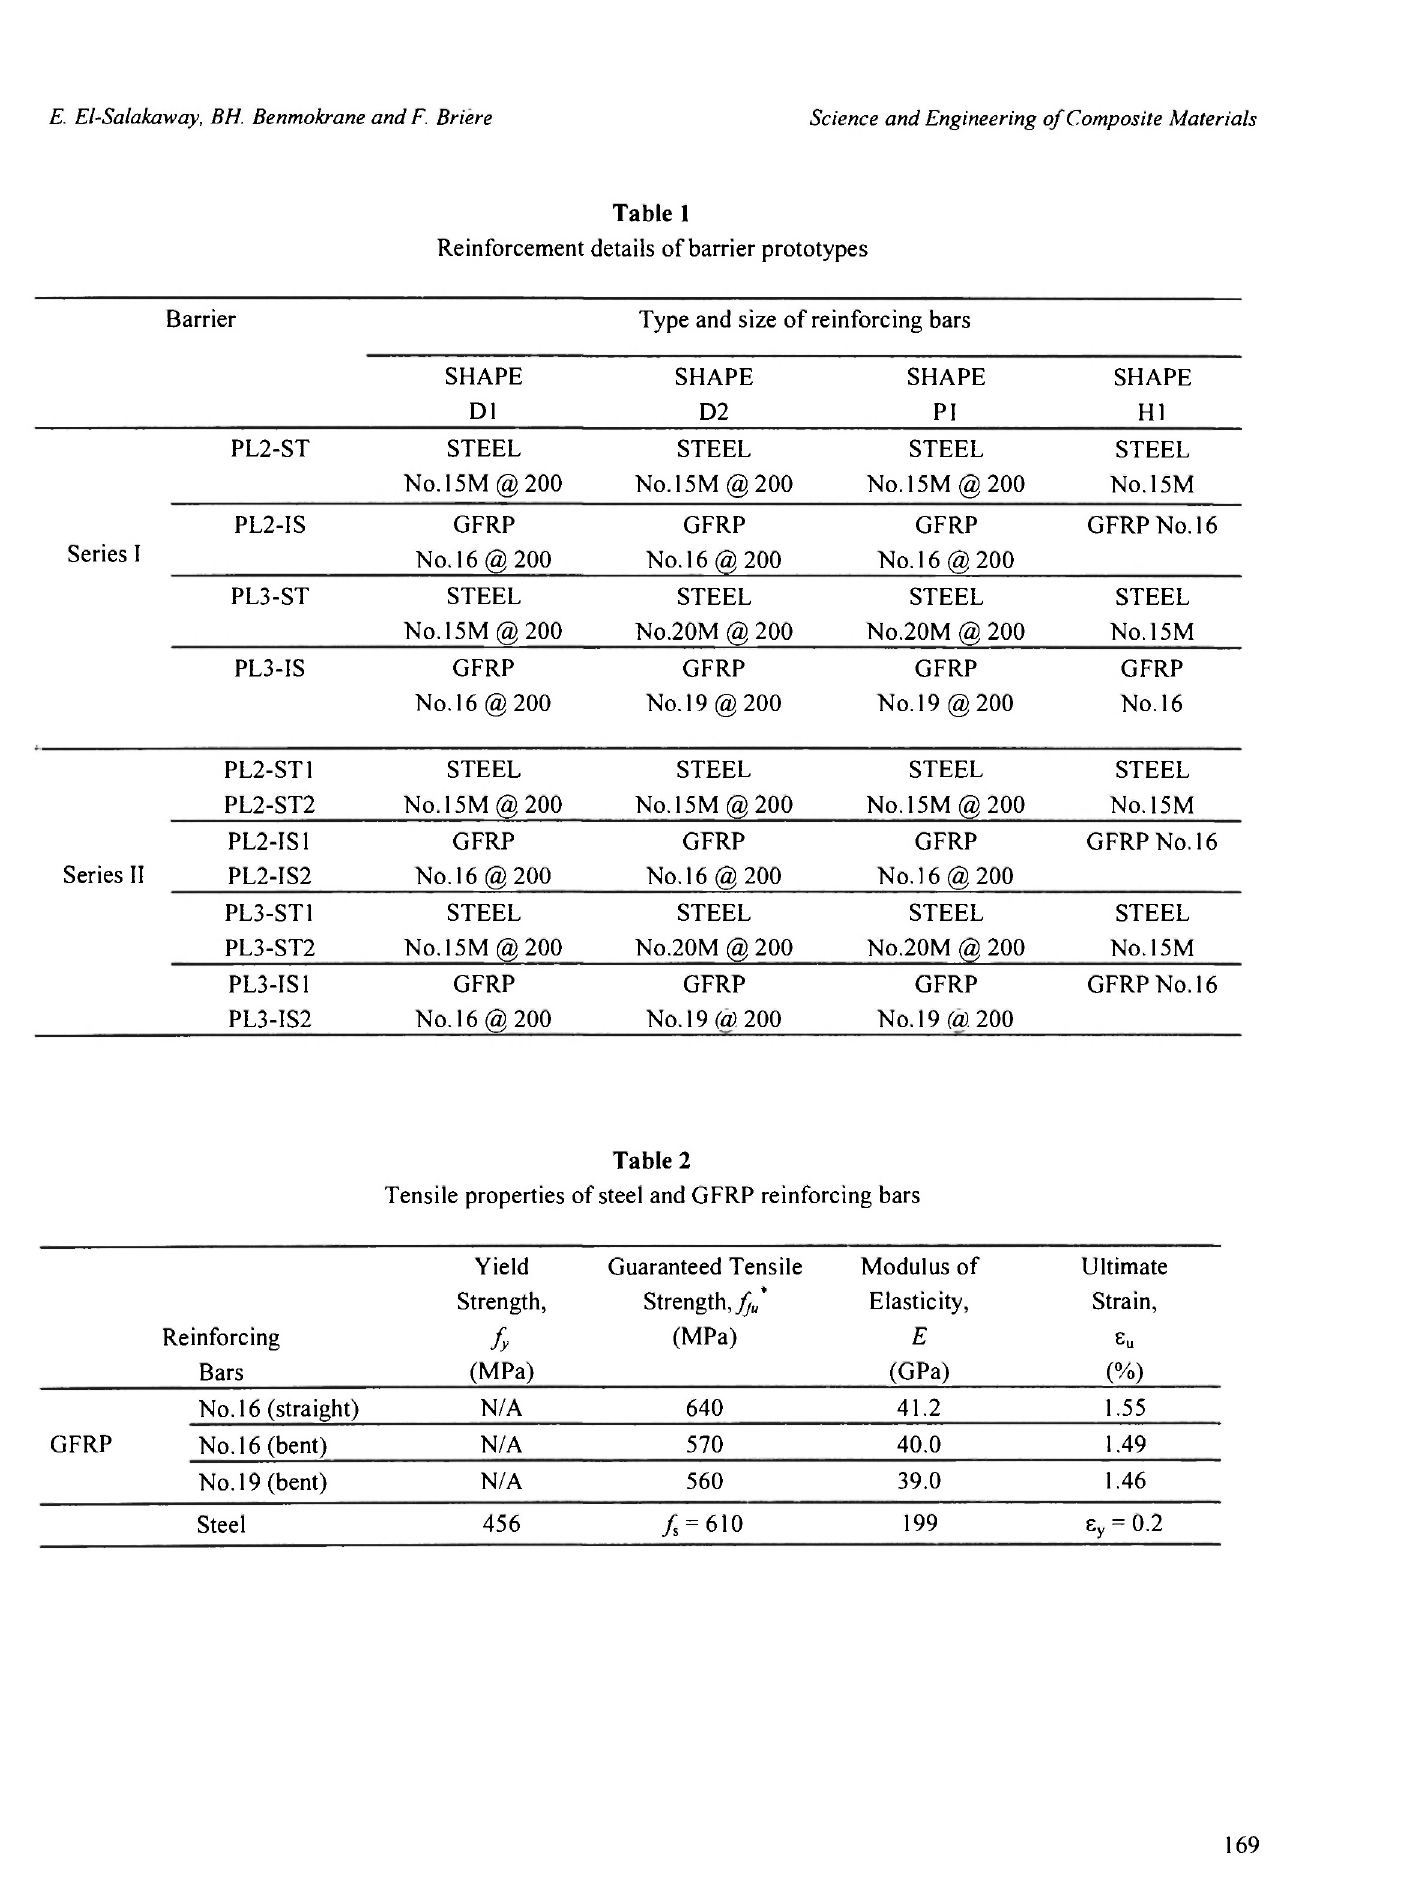
Tensile properties of steel and GFRP reinforcing